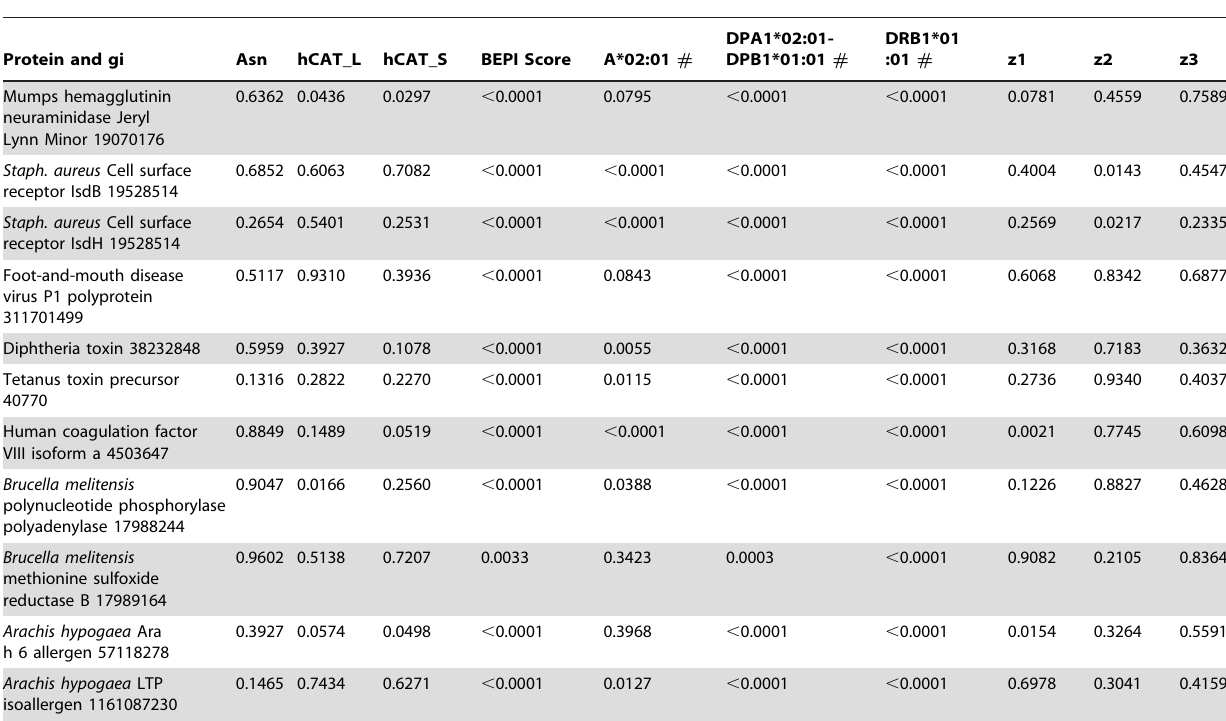
Table 1. Fisher’s Kappa statistic test p-values for presence of periodic components in protein sequences.